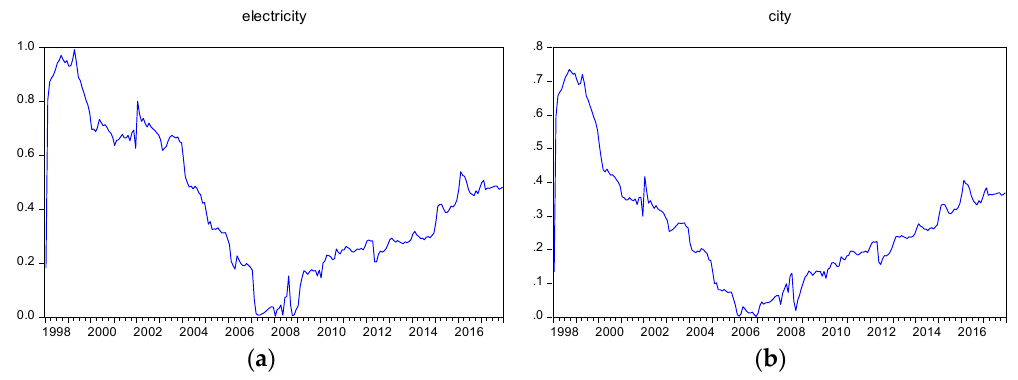
Figure 4. ( a ) The elasticity of generation gas. ( b ) The elasticity of urban gas.